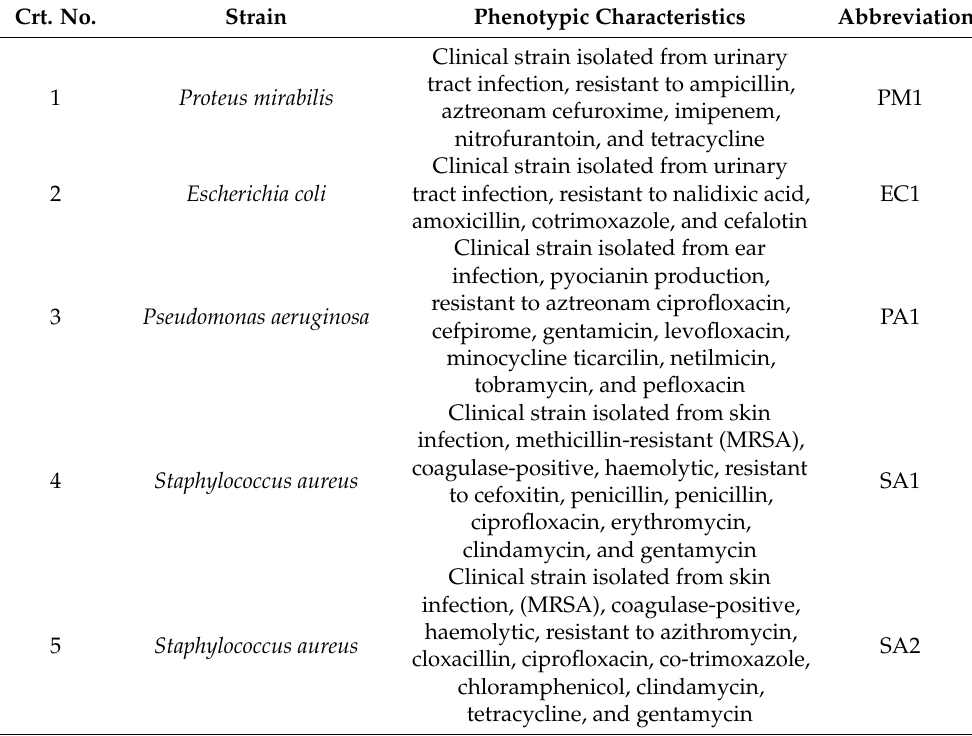
Table 1. Bacterial strains tested against SAM1, AM1, and their combination with T21. Crt.